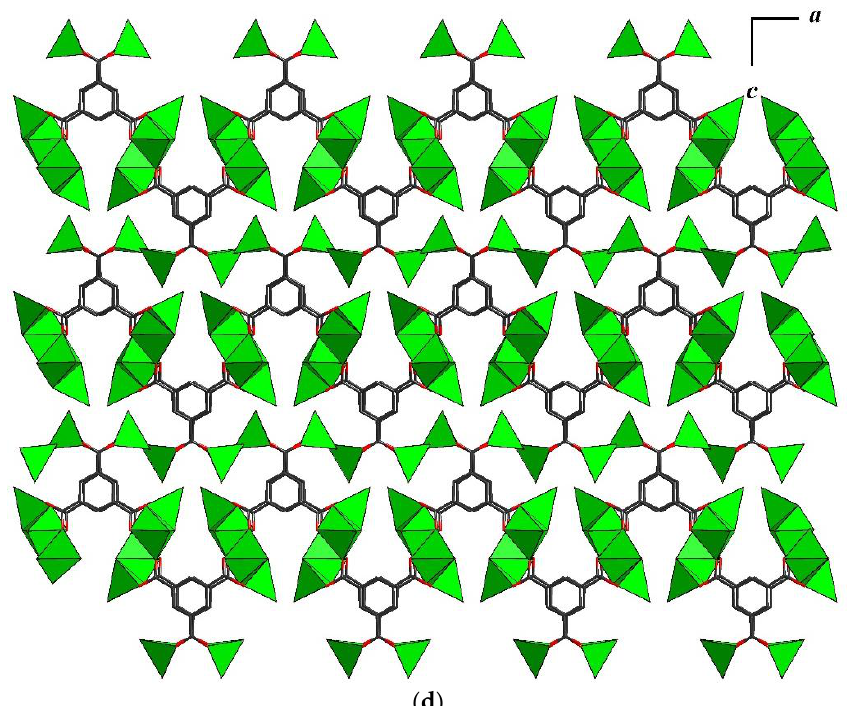
Figure 2. ( a ) The coordination spheres of lithium atoms in 2 ; ( b ) the coordination model of the BTC ligand in 2 ; ( c ) the one-layer structure view along the c -axis of 2 (H atoms were omitted for clarity); ( d ) the 2-D sheets viewed along the b -axis of 2 .